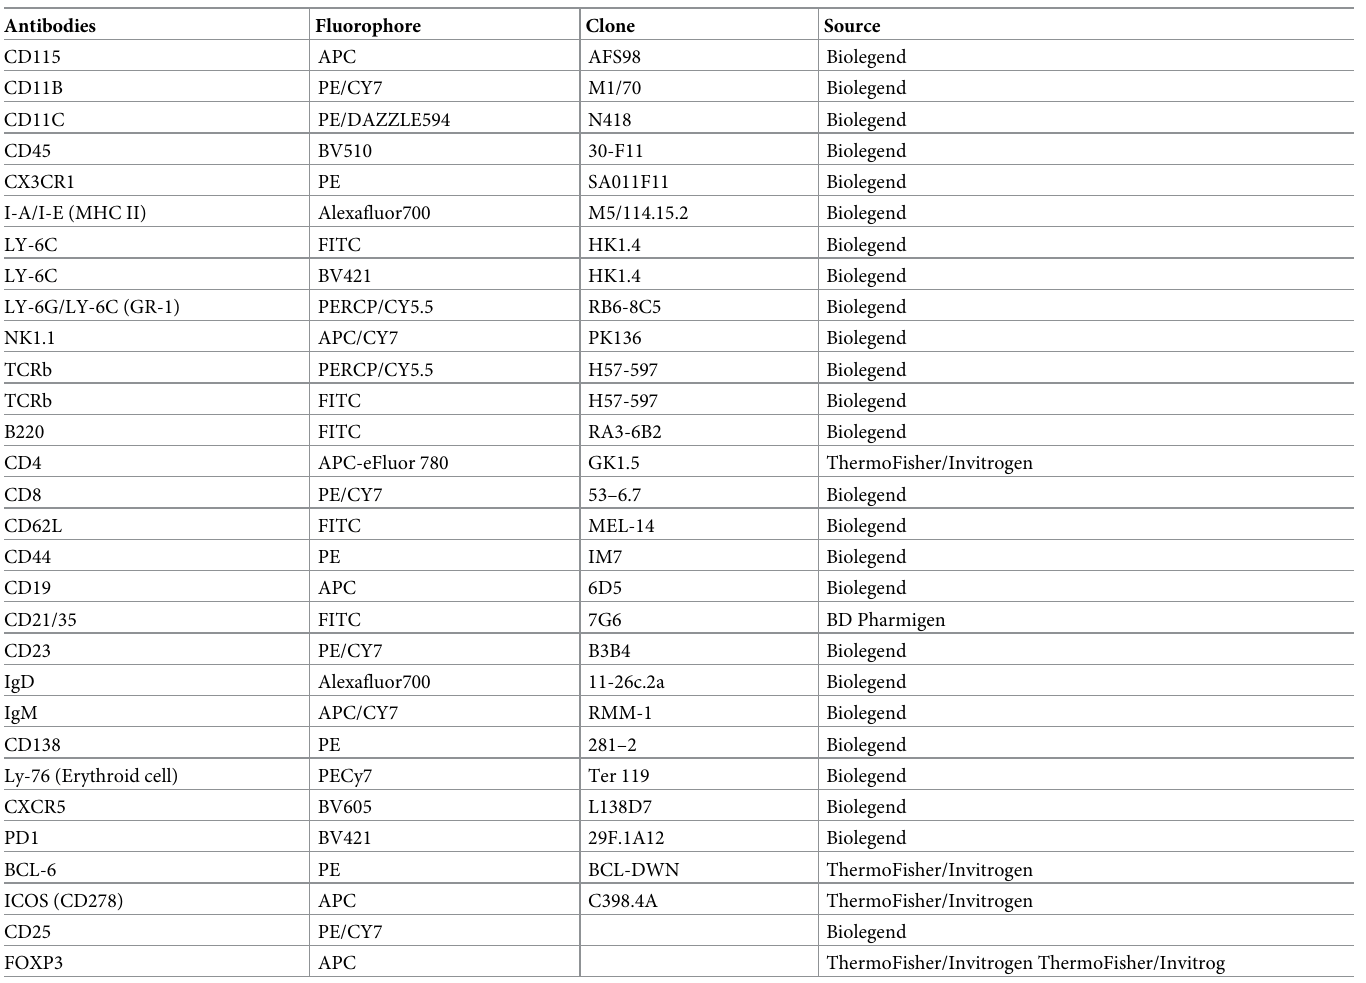
Table 1. List of antibodies used for the flow cytometry analysis of various immune cell